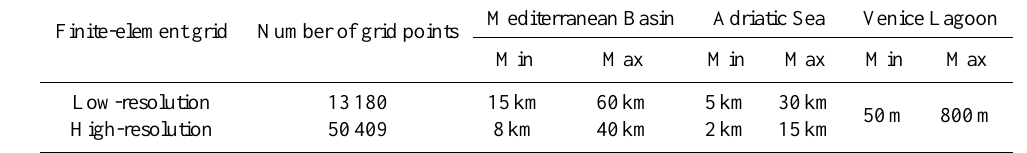
Table 2. Parameters of the low- and high-resolution finite-element grids of SHYFEM.